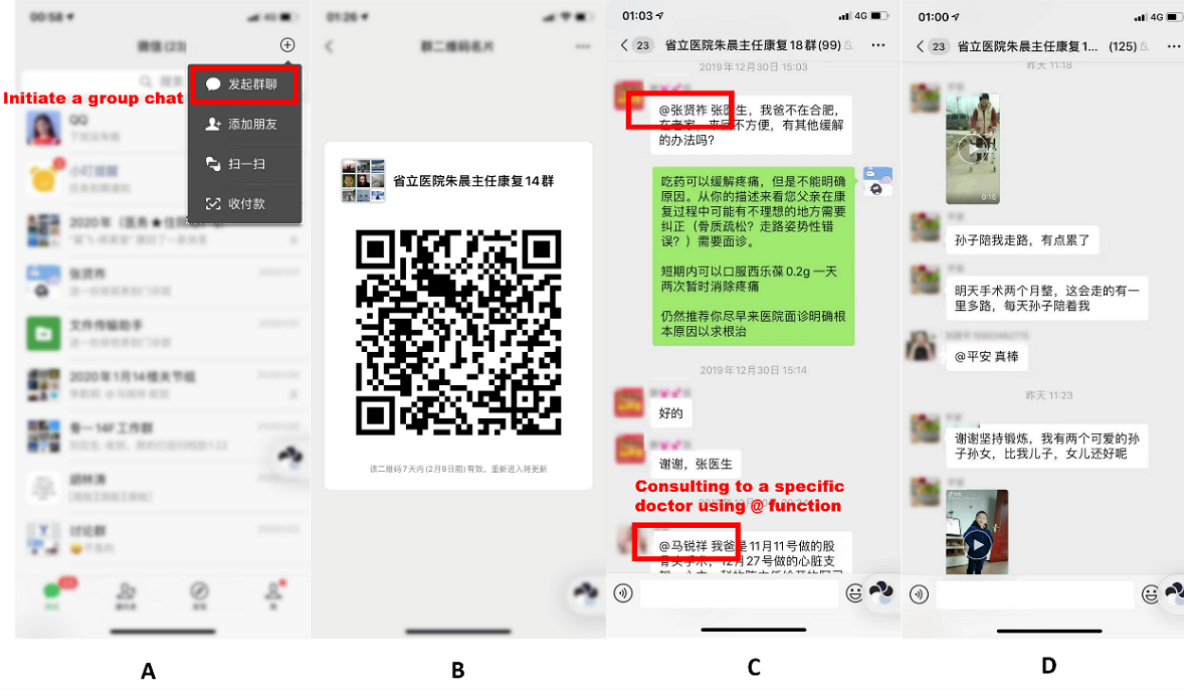
Figure 1. Creation of a chat group using the smartphone social media app WeChat. (A) Initiation of a group chat with personal contacts. (B) Generation of a QR code for patient invitation. (C) Consultation with a specific doctor/nurse/therapist using the @ function. (D). Sharing of treatment and rehabilitation experiences with video clips. Note that patient profile photos and names are